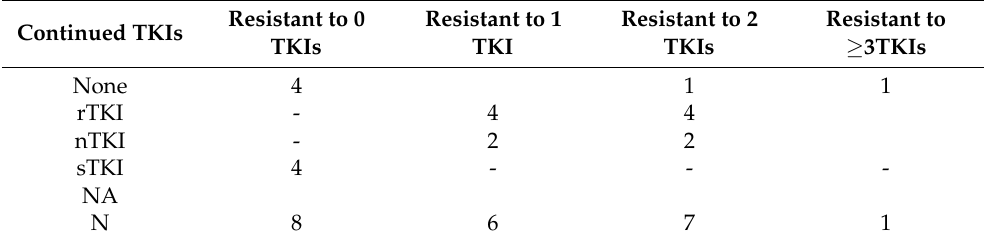
Table 5. Application of TKIs in 22 patients with defined lesions before and after radiotherapy.